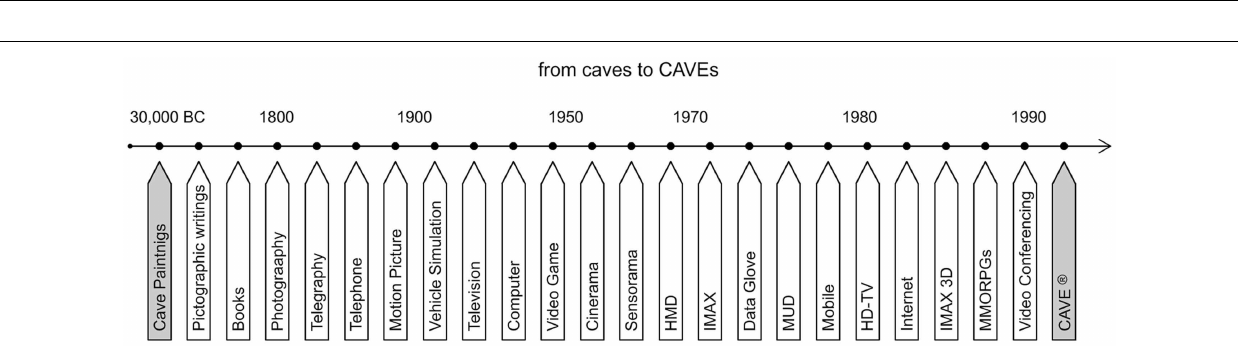
FIGURE 1 | Spatiotemporal illusion due to mediation: reality so evoked generates the experience of presence.